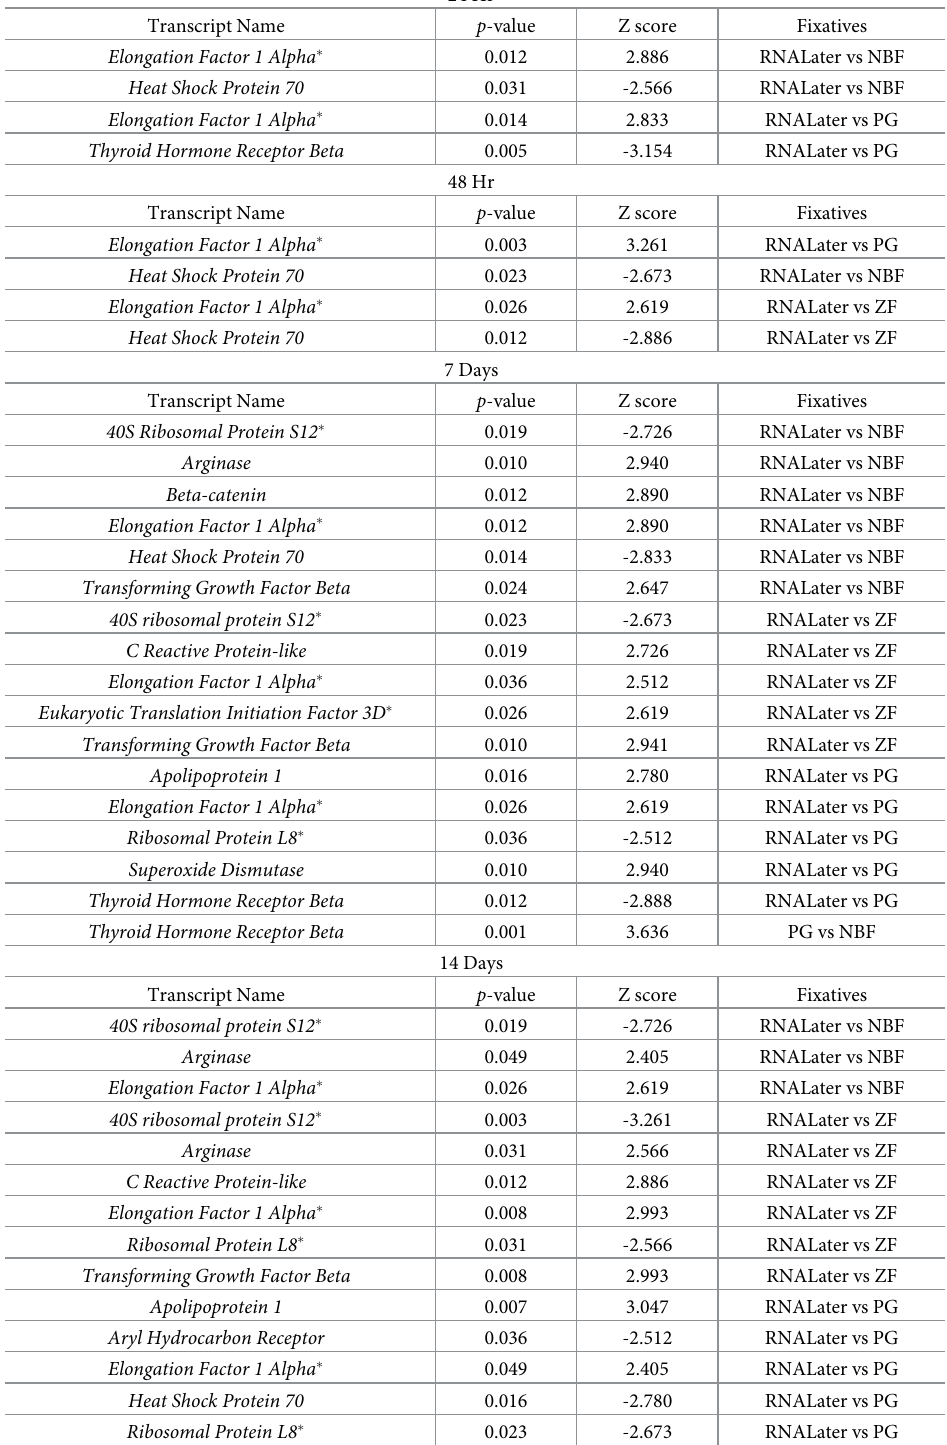
Table 2. Kruskal-Wallis non-parametric ANOVA results: Significant differences in transcript abundance between fixatives for each fixation